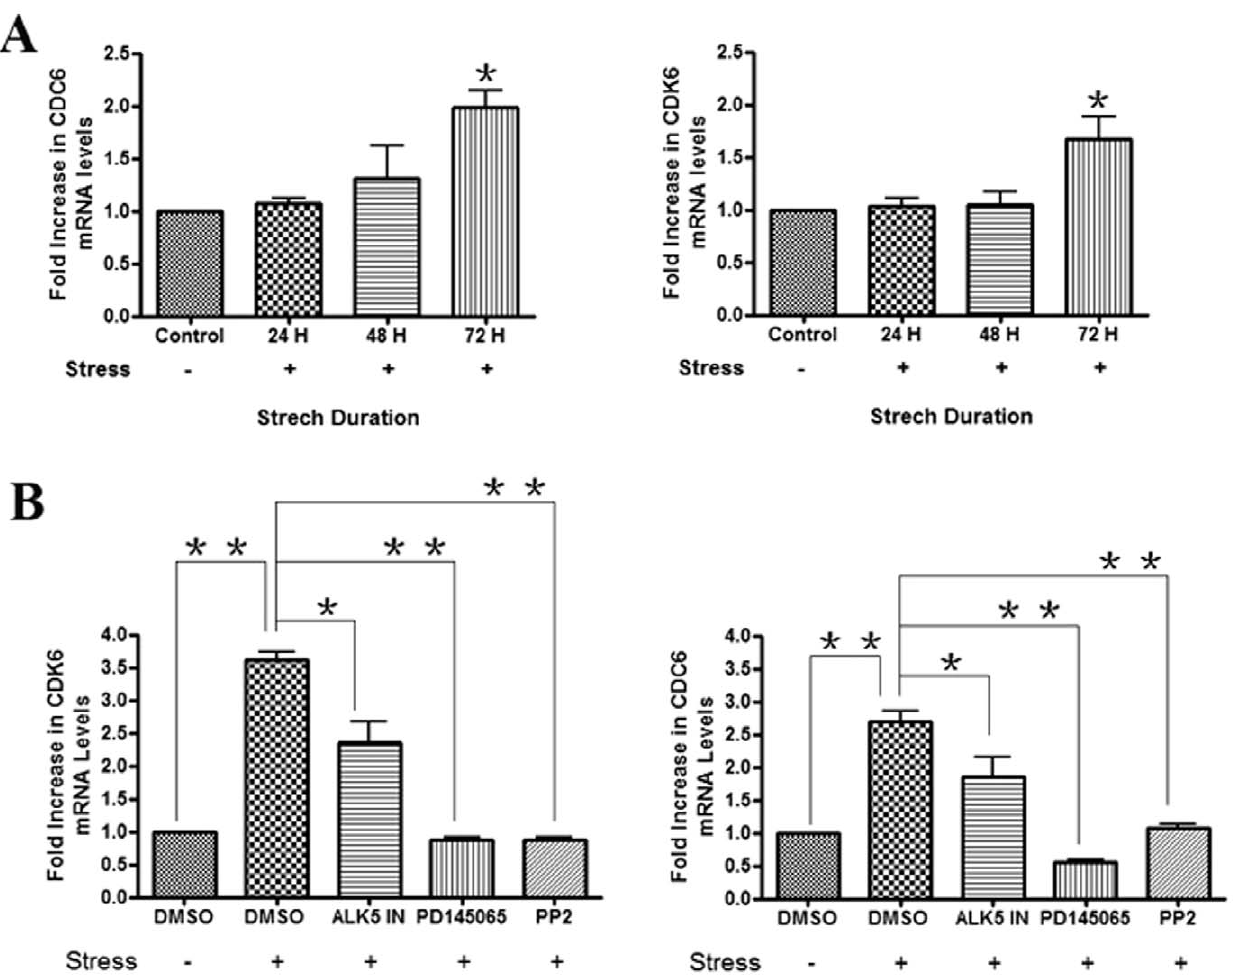
Figure 6. Strain induces cdc6 and cdk6 mRNAs in human gingival fibroblasts. (A) As described in Methods, equal numbers of HGF were seeded into plates containing collagen type I-coated membranes, and were treated with or without mechanical strain for up to 72 hours. Total RNA was harvested, and subjected to real-time PCR analysis with primers detecting cdc6 and cdk6 mRNAs. Expression values are adjusted to those of controls (18S) run in parallel. (B) Experiments similar to those performed in (A) were conducted with or without mechanical strain (72 hours) in the presence or absence of DMSO, the ALK5 inhibitor SB431542, PP2, blebbistatin or the ETA/B receptor antagonist PD145065, as indicated. Total RNA was harvested, and subjected to real-time PCR analysis with primers detecting cdc6 and cdk6 mRNAs. Expression values are adjusted to those of controls (18S) run in parallel. Data shown are the average value from three independent individuals (3 replicates per experiment ) 6 SE. *=p , 0.05; **=p ,